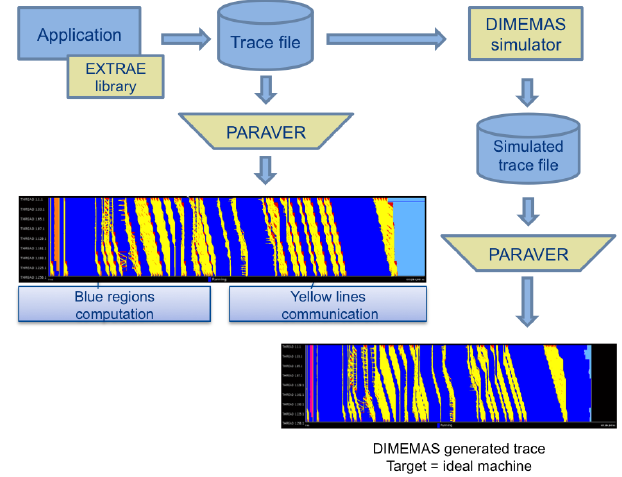
Figure 7. Understanding model performance on existing machines generally requires instrumenting the model code to output “trace” information that can be analysed and visualised by a dedicated ap- plication. This information can also be used, when combined with machine information, to predict performance (issues) on alterna- tive architectures. This figure depicts the use of PARAVER (Labarta et al., 2005) for collecting trace information and DIMEMAS (Gon- zalez et al., 2011) for simulating performance on alternative archi-